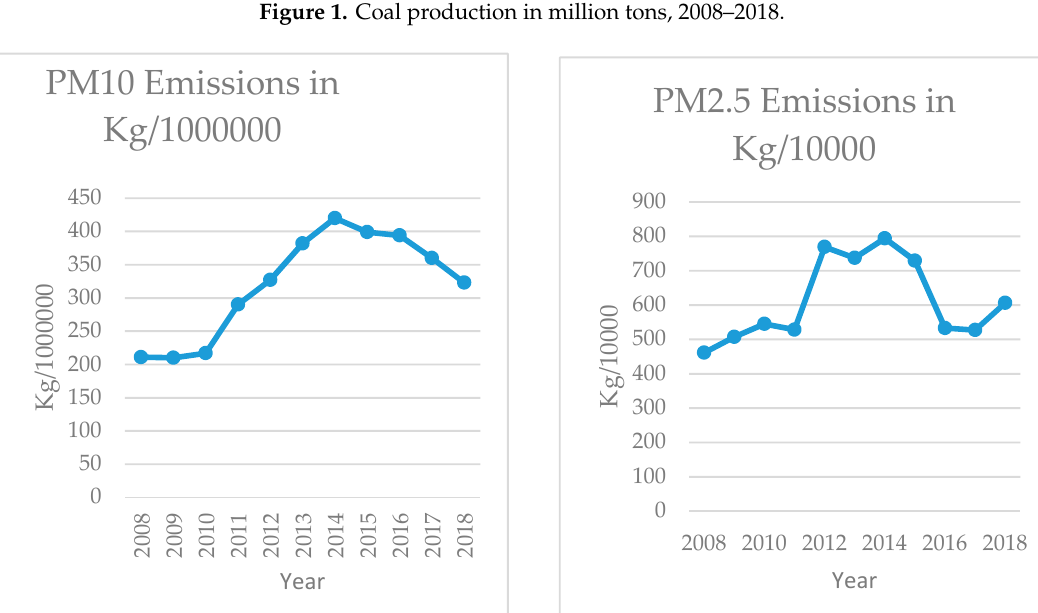
Figure 1. Coal production in million tons, 2008–2018.